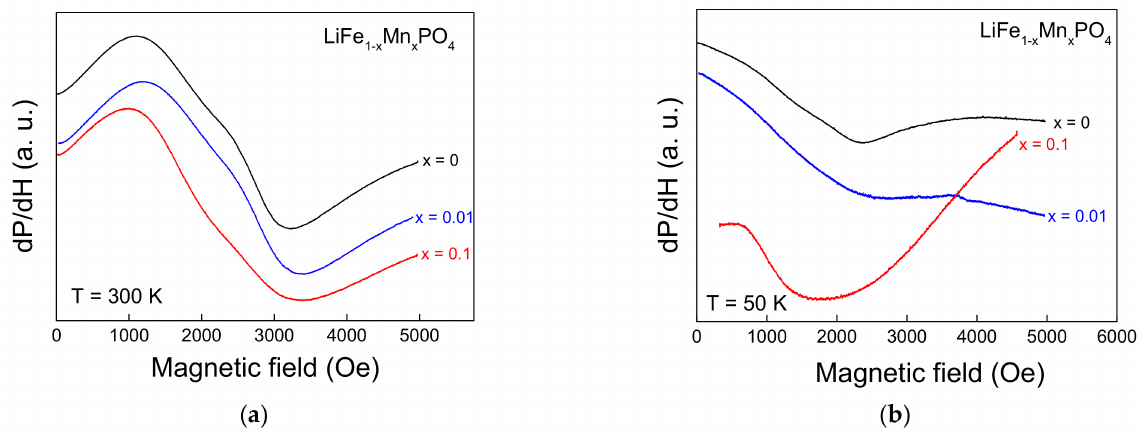
Figure 2. ESR spectra of LiFe 1 − x Mn x PO 4 at the temperatures of ( a ) 300 K and ( b ) 50